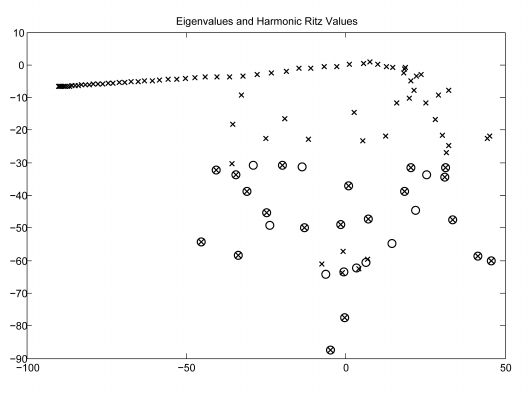
Figure 11: The first 30 eigenvalues of the system matrix with the smallest imaginary part (circles) and the first 50 harmonic Ritz values (crosses) for the plasmonic waveg- uide problem.